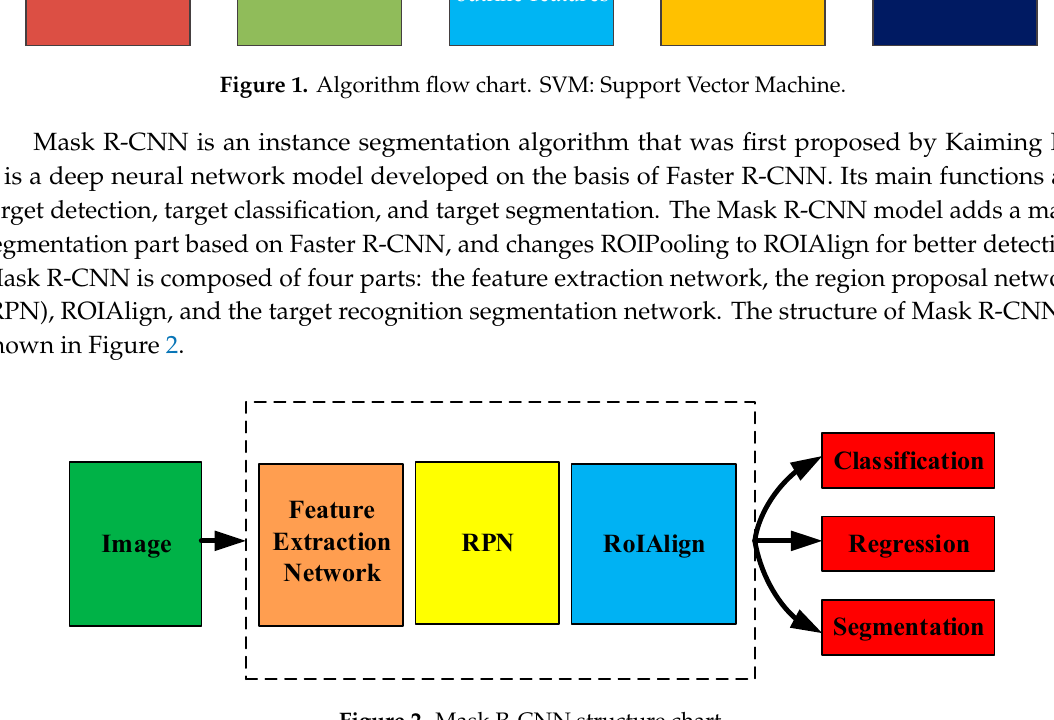
Figure 2. Mask R-CNN structure chart.